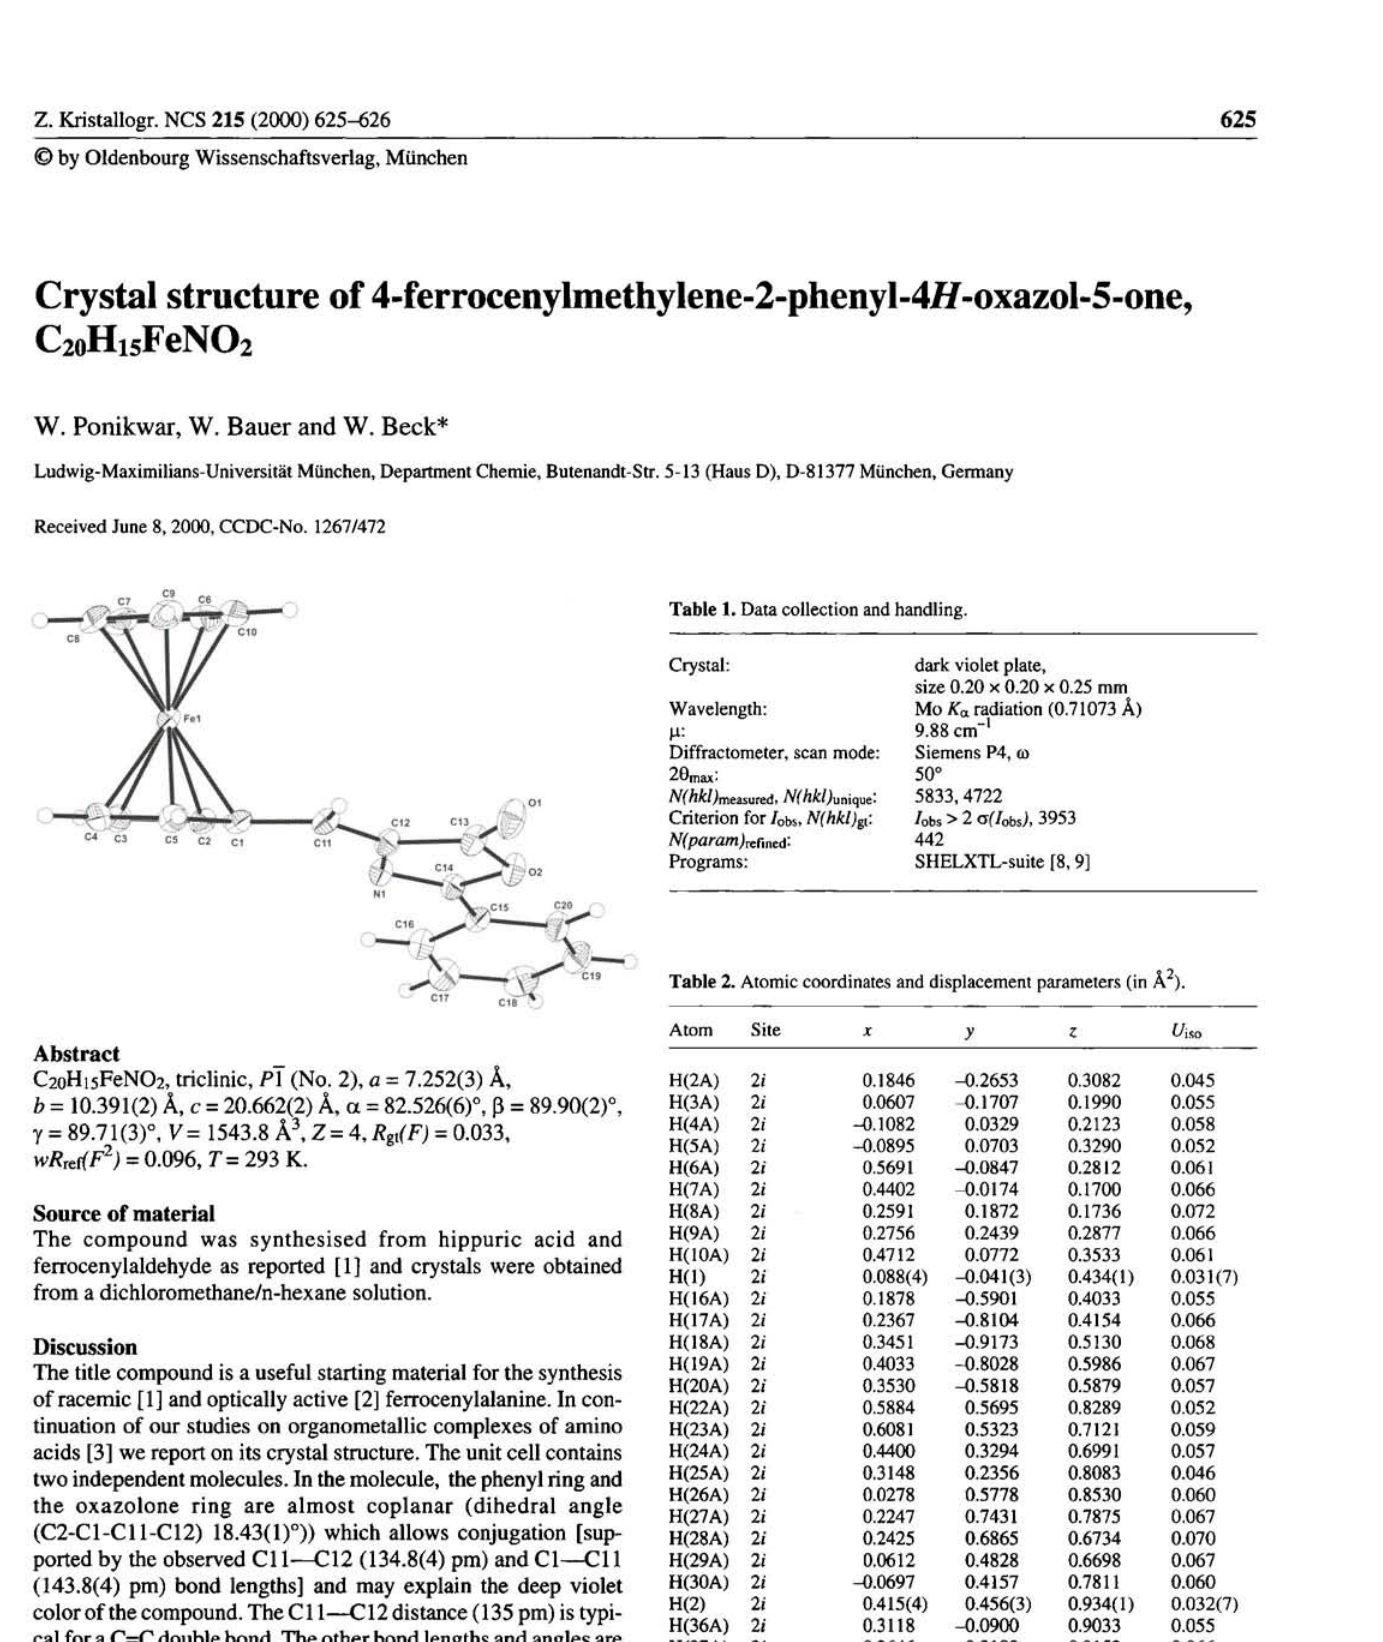
Table 2. Atomic coordinates and displacement parameters (in Ä 2